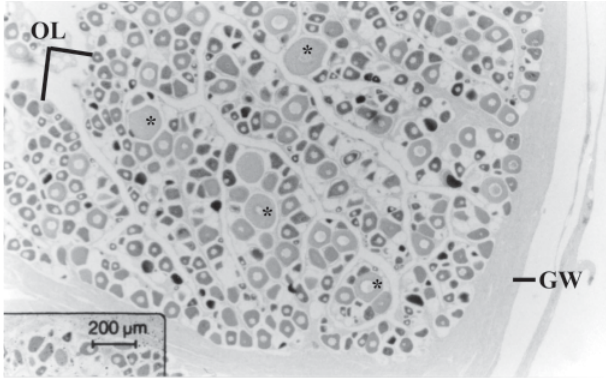
Fig. 5 . Transverse section of an early maturation ovary of